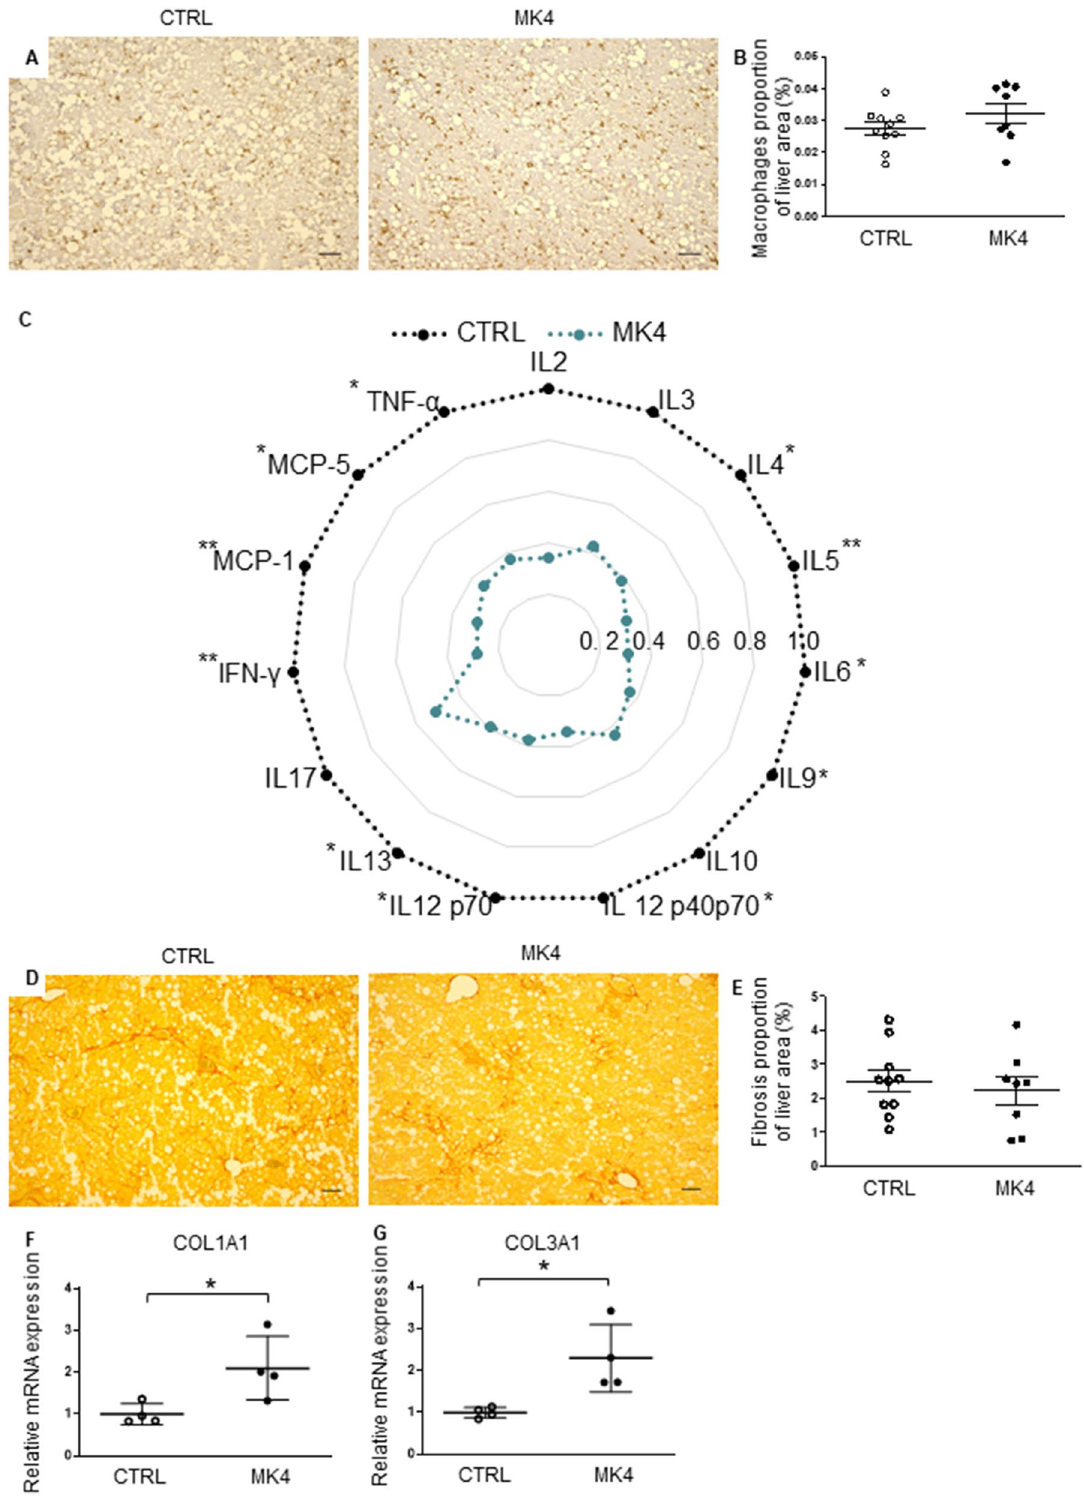
Figure 5. Hepatic effects of menaquinone 4 in LDLr −/− ApoB 100/100 mice. ( A ) Representative images of liver macrophages determined by immunohistochemistry of CD68 + and ( B ) quantification of macrophages in the liver in CTRL (n = 10) and MK4 (n = 8) mice. ( C ) Cytokine array was done from hepatic tissue of control (n = 6) and MK4 (n = 6) mice. Quantification of the relative expression levels of selected cytokines and chemokines ( D ) Picro sirius red staining for fibrosis and ( E ) quantification of fibrosis in CTRL (n = 10) and MK4 (n = 8) mice. Gene expression of collagens ( F ) (Col)1a1 and (G) Col3a1 in CTRL (n = 4) and MK4 (n = 4) mice. CTRL, LDLr −/− ApoB 100/100 mice on Western diet (WD); MK4, LDLr −/− ApoB 100/100 mice on WD with menaquinone 4. IL, interleukin; IFN-γ, interferon gamma; MCP, monocyte chemoattractant protein, TNFα, tumour necrosis factor alpha. Student´s t-test was used for statistical analysis. * p < 0.05, ** p < 0.01. Student´s t-test was used for statistical analysis. Scale bars are 200 µm. p <